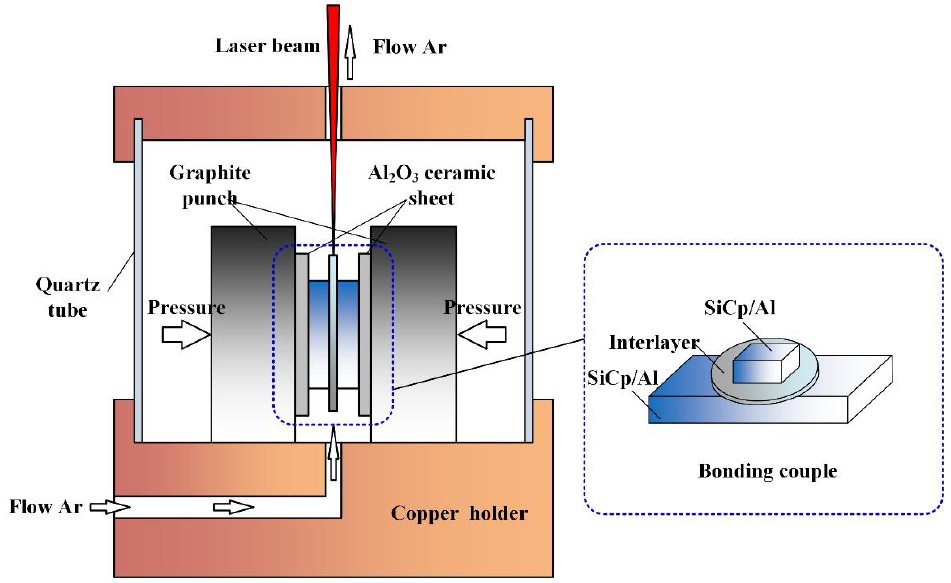
Figure 2. Schematic diagram of the bonding process.